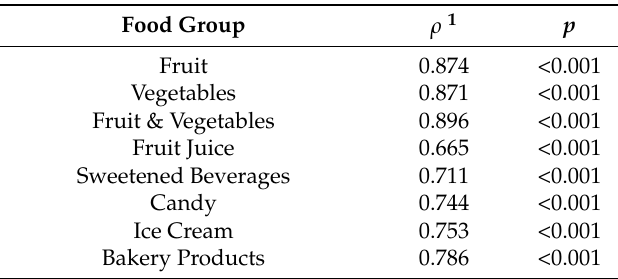
Table 2. Correlation coefficient between average food intake (g/day) estimated by means of TECH and 24 h dietary recalls 1 ( n =